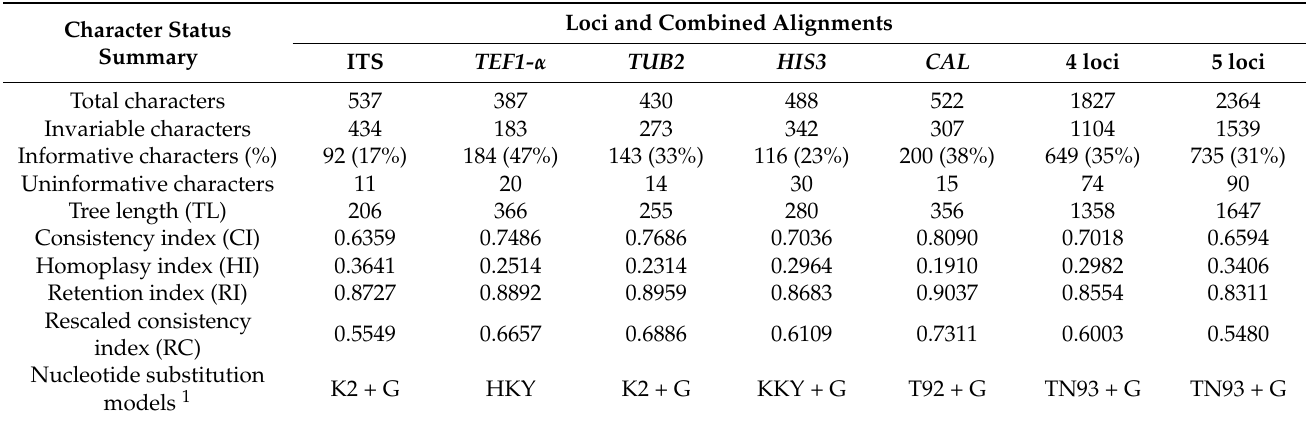
Table 2. Alignment properties and nucleotide substitution models used for phylogenetic